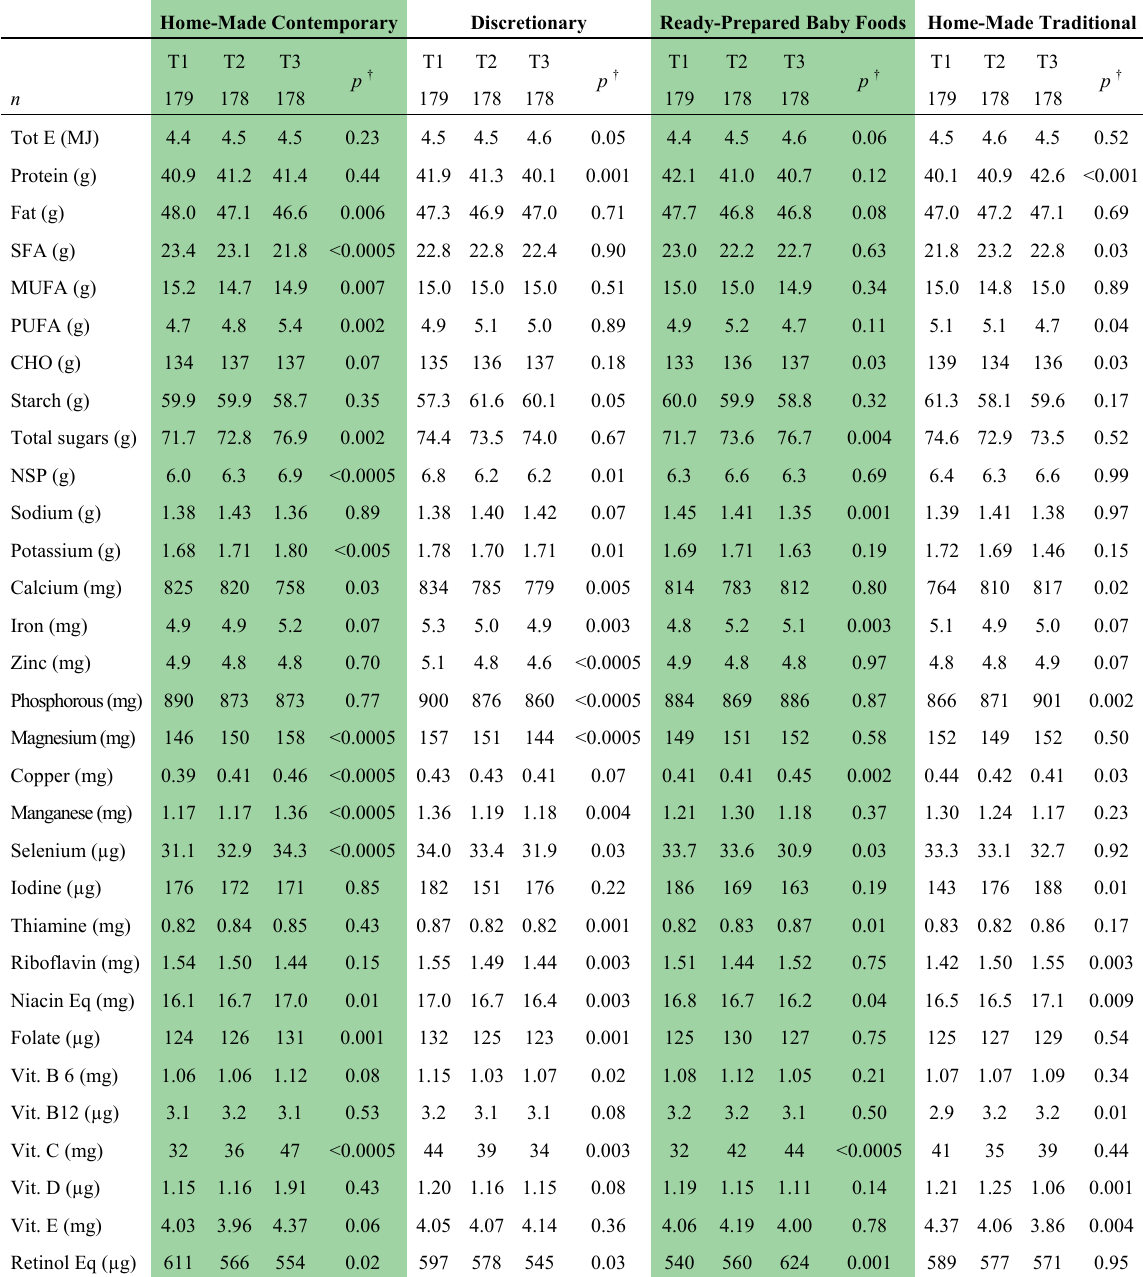
Table 3. Median energy and energy-adjusted nutrient intake * at 18 months of age, according to tertiles of dietary pattern scores at 15 months ( n =